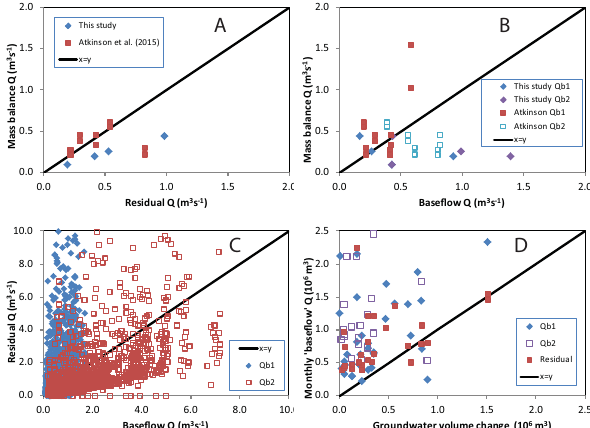
Figure 9. Scatter plots showing various estimates of baseflow and groundwater discharge. (a) Mass balance tracer estimates (from Atkinson et al. (2015) for 2011–2012 and the mid-point of the range shown in Table 1 for 2013) for groundwater discharge against the residual streamflow (Bunker Hill streamflow less upstream gauged streamflow). (b) Mass balance tracer estimates against the Eckhardt filter baseflow estimates (Qb1 uses a = 0 . 988 and BFI max = 0 . 2; Qb2 uses a = 0 . 988 and BFI max = 0 . 6). (c) Residual discharge against Eckhardt filter baseflow time series for 2007–2013. (d) Satu- rated volume changes (using specific yield set 0.15, 0.30, 0.05 from Table 2) against residual flow and Eckhardt filter baseflow time se-